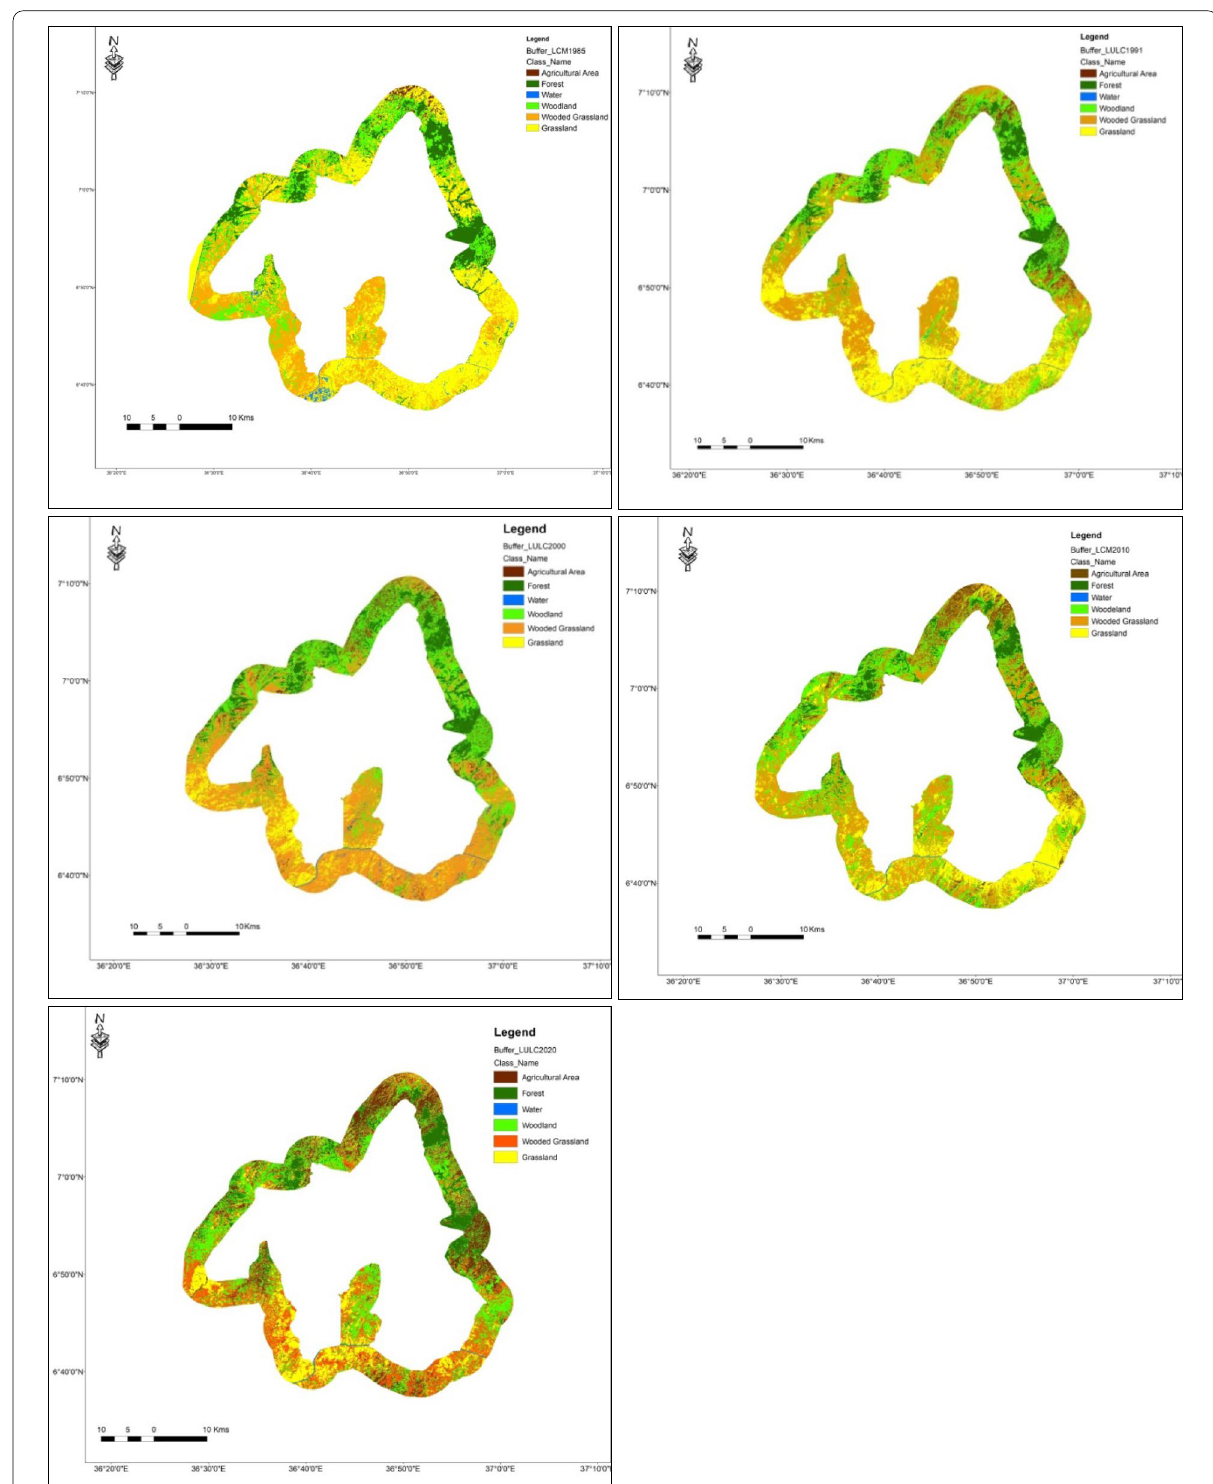
Fig. 3 Land use land cover classes in the park buffer zone areas, from top-left to bottom-right, in 1985, 1991, 2000, 2010 and